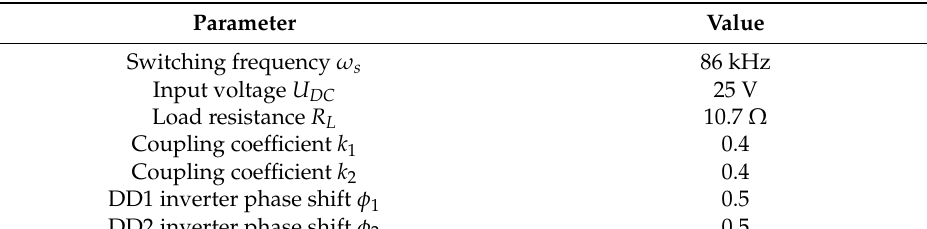
Table 2. Operating point of the double DD coil system.